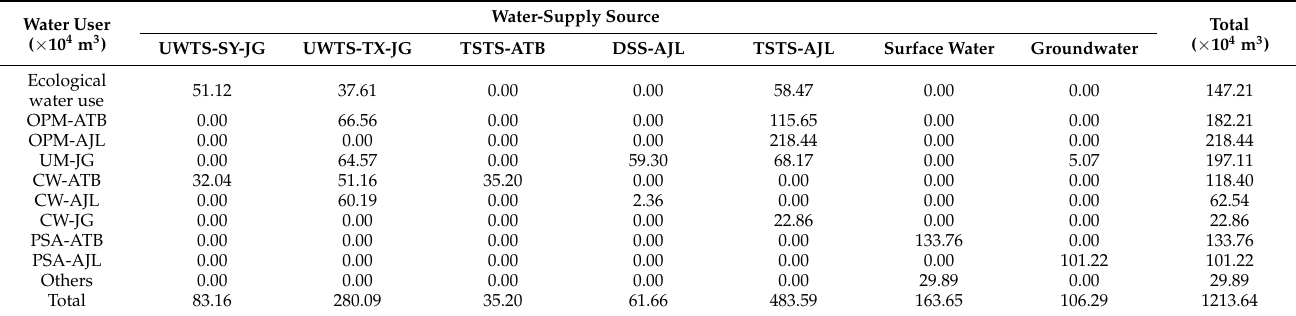
Table 11. Calculation results of water resources optimal allocation in the study area.